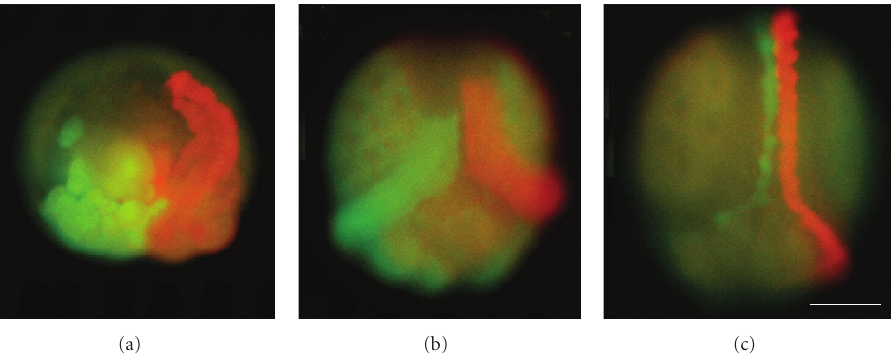
Figure 7: Tpr antisense oligonucleotides a ff ected proteloblast, but not teloblast, cell development. (a) Proteloblast NOPQ (right) was microinjected with Tpr sense oligonucleotide TprC (co-injected with RDA; red) and displayed a normal bandlet pattern, while NOPQ (left) microinjected with Tpr antisense oligonucleotide TprB (co-injected with FDA; green) proliferated abnormally; representative embryo harvested at ∼ 36 hours post-injection. (b) M (right) teloblast microinjected with TprC (sense; red) appeared normal ∼ 50 hours later; M (left) microinjected with TprB (antisense; green) also appeared normal (the disparity in the extent of each germinal band resulted from the ∼ 2 hours delay between sense and antisense microinjections). (f) N (right) teloblast microinjected with TprC (sense; red) appeared normal ∼ 72 hours later; N (left) microinjected with TprB (antisense; green) appeared relatively normal. Scale bar = 200 μ